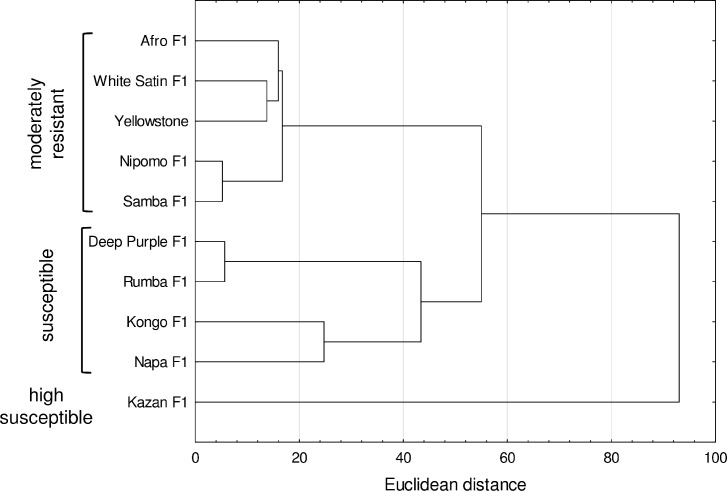
Dendrogram showing the clustering of carrot cultivars based on data
obtained from field assessments: Mean number of alates (migrants), mean
seasonal number of aphids per plant, mean number of aphids per plant at
peak abundance, mean percentage of colonized plants during aphid
migration, and mean percentage of colonized plants at peak aphid
abundance.